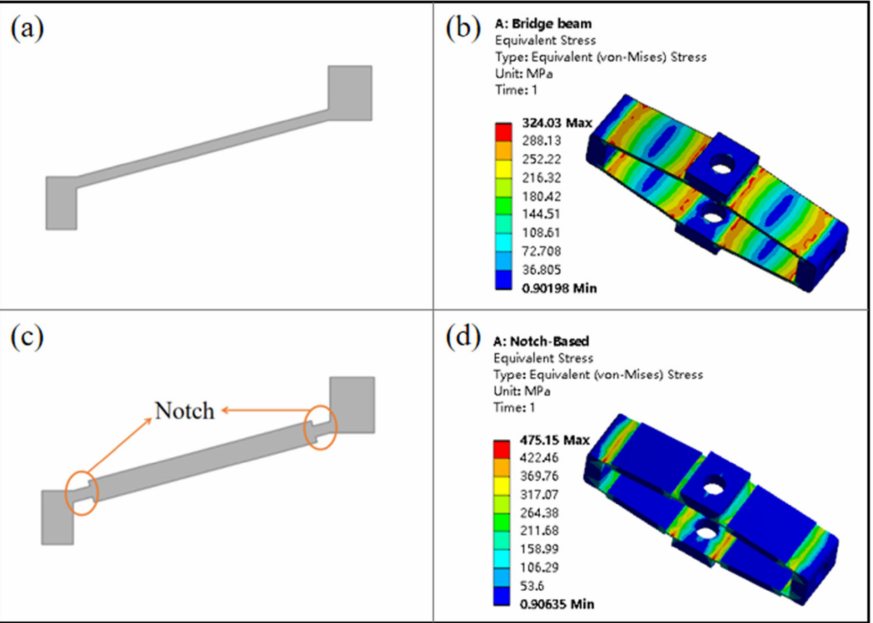
Figure 3. Structural and stress analysis of different beam types. ( a ) Bridge-type beam structural diagram; ( b ) Stress diagram of bridge-type beam; ( c ) Structural diagram of hinge beam; ( d ) Stress diagram of hinge